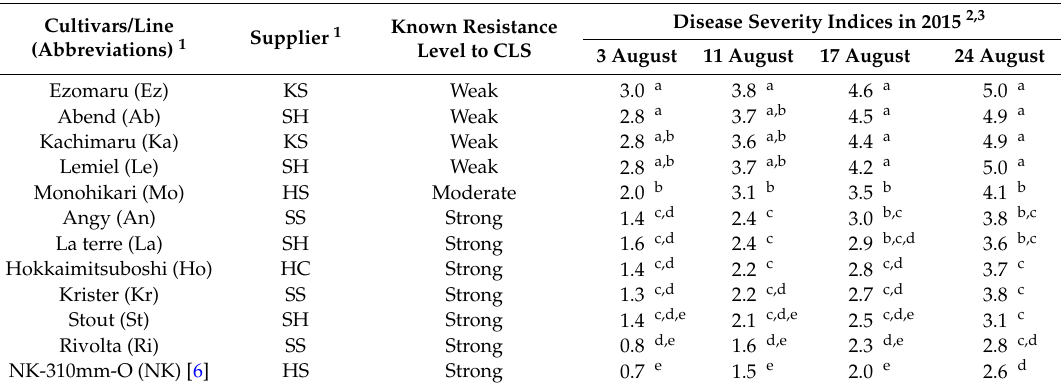
Table 1. Sugar beet cultivars or lines used in the present